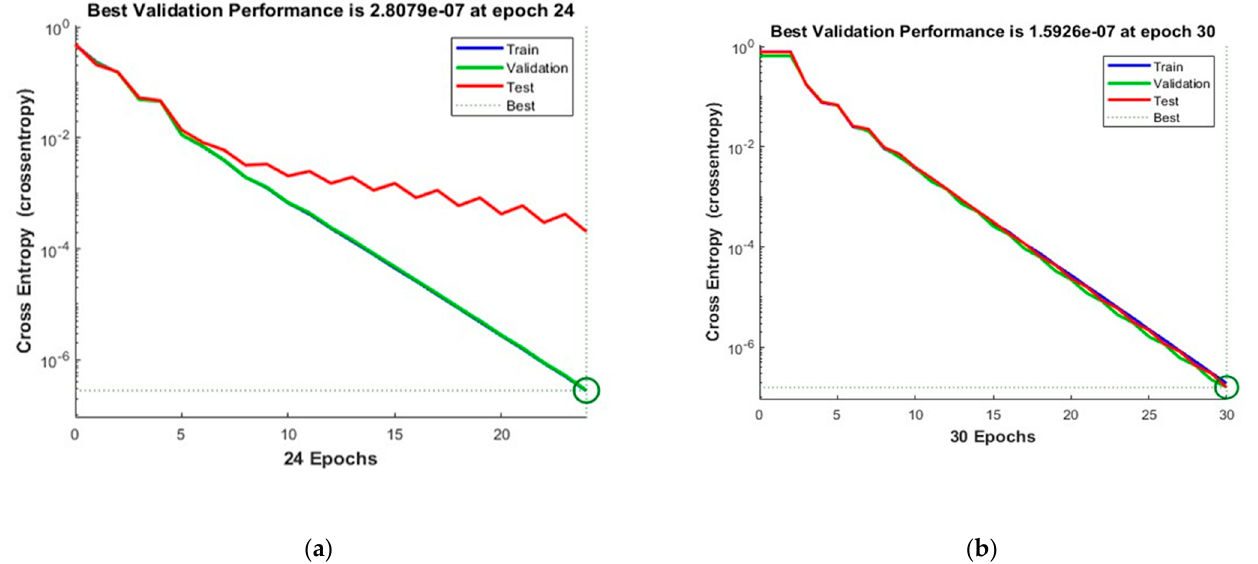
( b ) Figure 7. Confusion matrices of Dataset-1, where class label 1 shows Normal operating conditions and class label 2 shows the Leak operating conditions of the pipeline using ( a ) 10 Neurons and ( b ) 50 Neurons. Figure 8 shows the convergence curves for the best validation value 2.8079 × 10 − 7 at epochs 24 and 1.5926 × 10 − 7 at epochs 30 for 10 and 50 neurons, respectively. The conver-